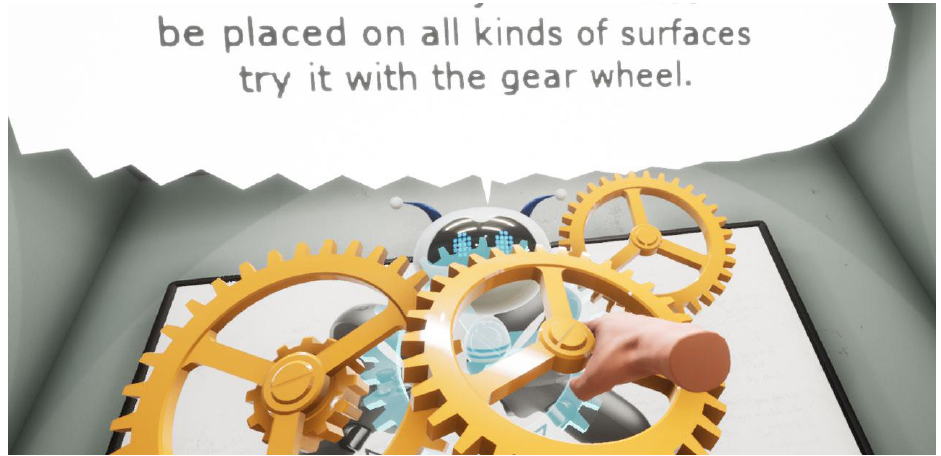
Figure 5. Example of a screen of the iVR tutorial where the assistant robot is a source of information that is complemented with information shown on the board.